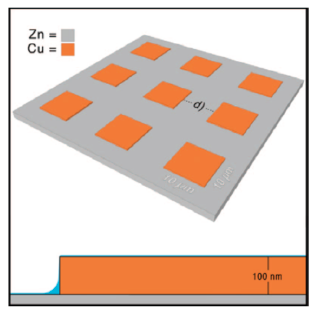
Figure 17. A schematic illustration of copper islands (brown) on zinc substrate (gray). Reproduced from reference [107] by permission of The Electrochemical Society. Copyright 2013.